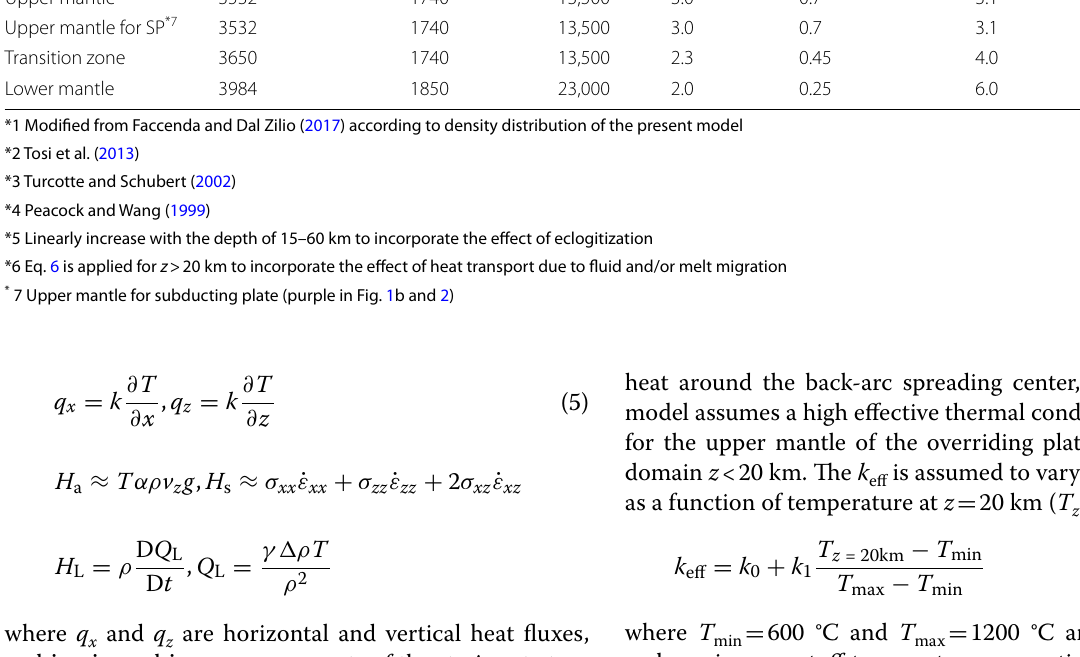
heat around the back-arc spreading center, the present model assumes a high effective thermal conductivity ( k eff ) for the upper mantle of the overriding plate within the